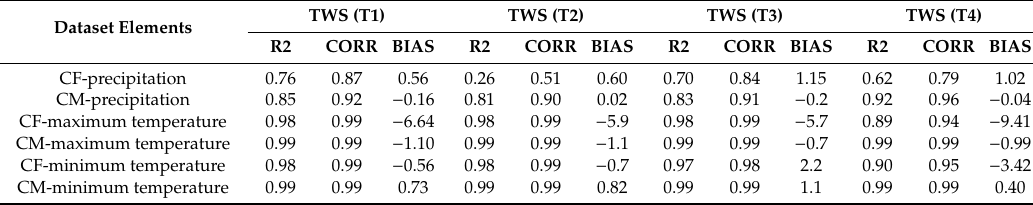
Table 3. Correlation analysis for CFSR and CMADS based on TWS at four sites (T1–T4). Dataset